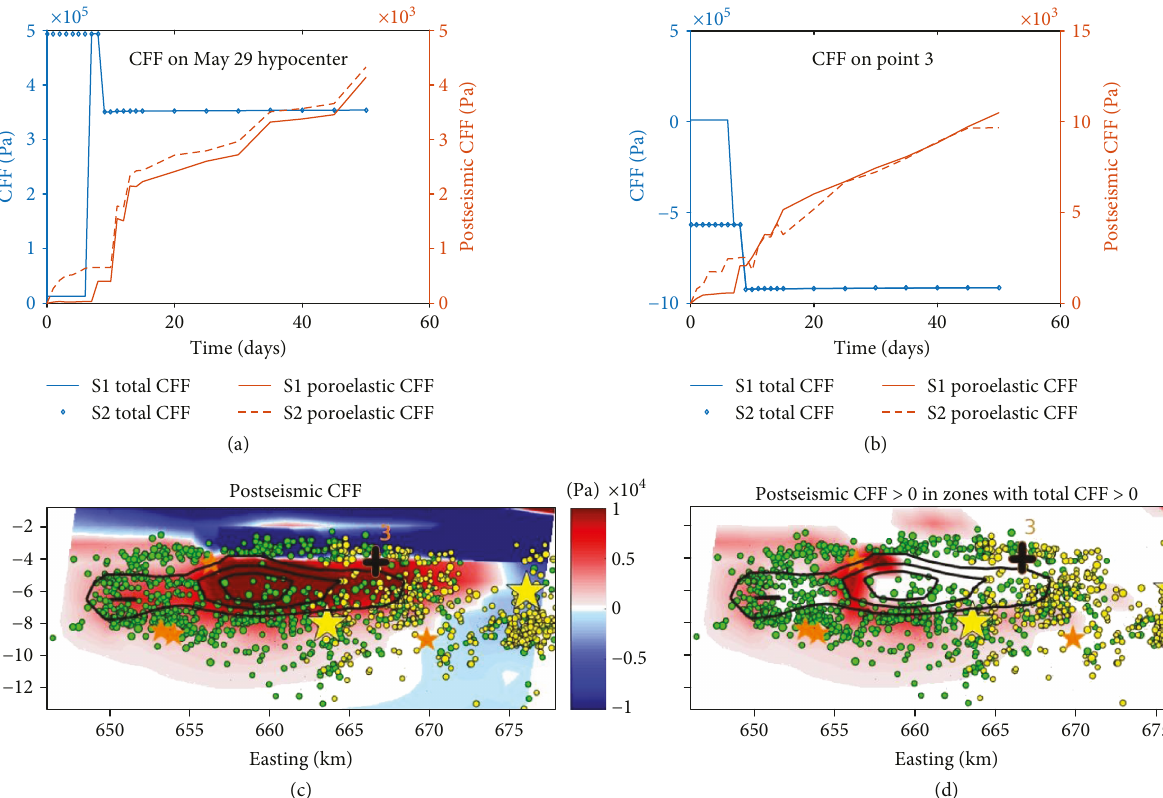
Figure 9: (a) Total CFF changes (blue plots) and poroelastic postseismic CFF changes (orange lines), in S1 (solid line) and S2 (dashed line) at the May 29 hypocenter. (b) The same as (a), but at point 3 (black cross in (c) and (d)). (c) Postseismic poroelastic-induced Δ CFF plotted on the Mirandola fault plane in S2 and (d) in regions of the fault where both the poroelastic contribution and the total change are positive. Yellow dots represent the seismicity before May 29; green dots represent seismicity after May 29. Yellow stars represent the location of the two ≥ 5 events. The contour represents the slip distribution of the May 29 mainshocks. Orange stars represent the M L